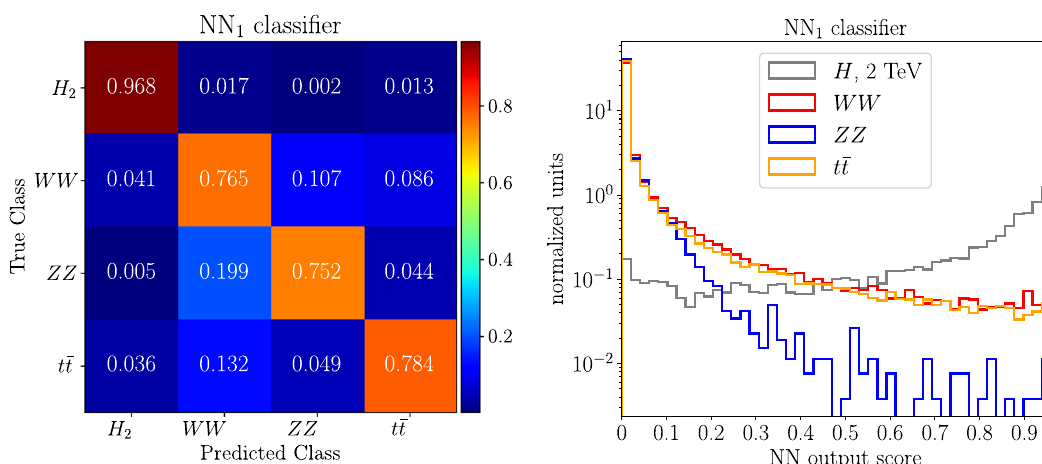
Fig. 5 Confusion matrix of the classification and the output scores of the neural network before M (cid:2)(cid:2)νν regression at the left and right panels, respectively, for a 2 TeV Higgs boson and its main SM backgrounds